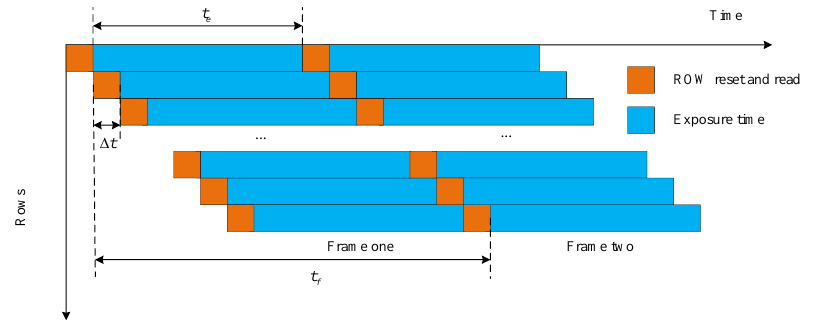
Figure 4. Schematic diagram of rolling shutter exposure mode.